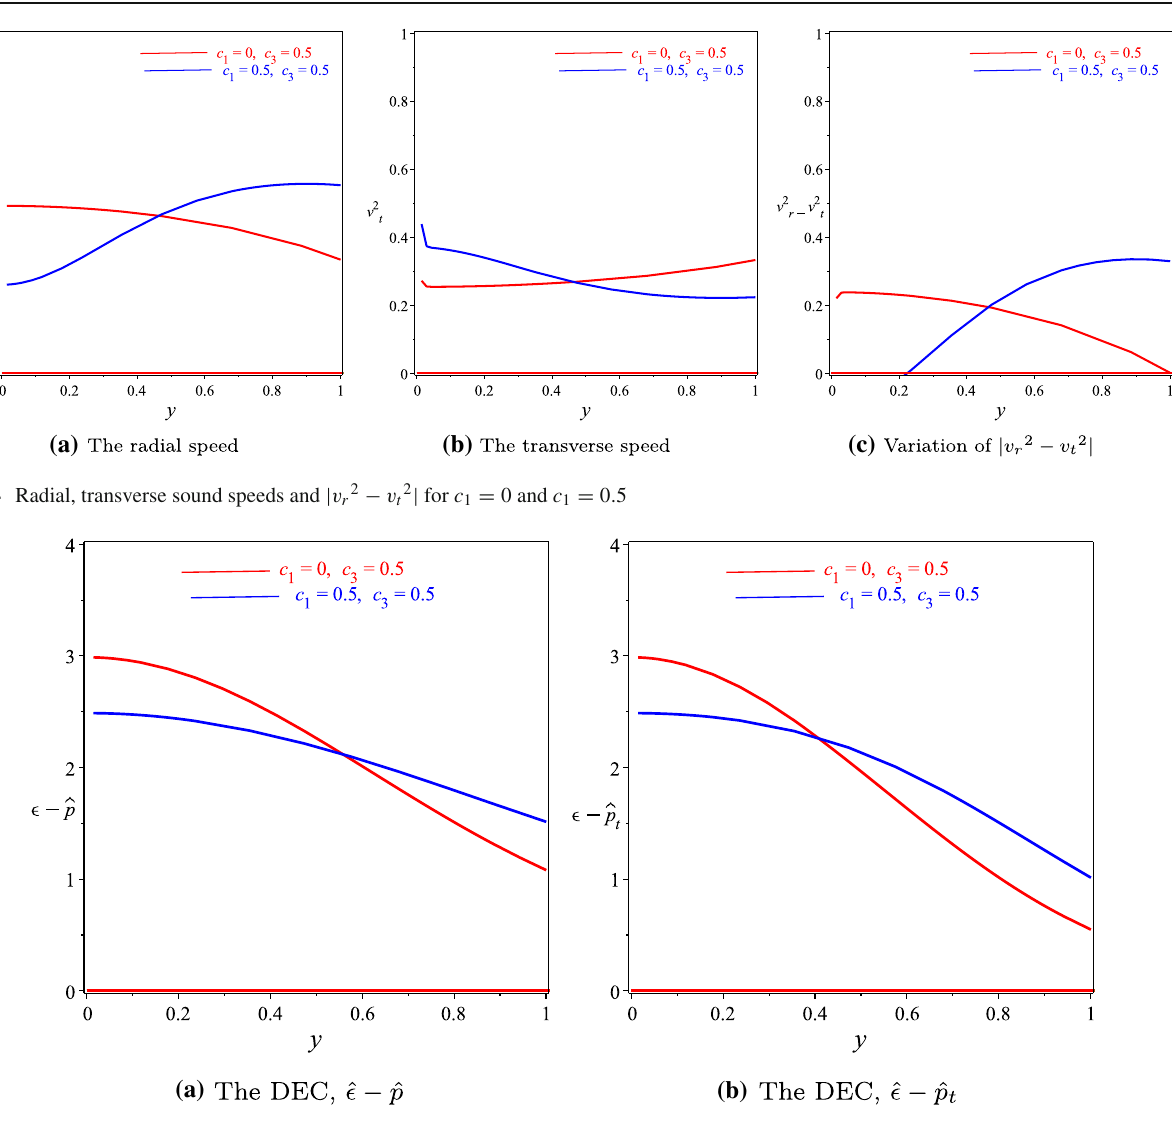
Fig. 5 DEC for c 1 = 0 and c 1 = 0 .